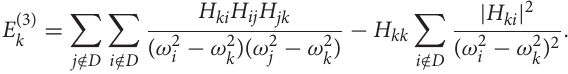
5 and t 1, for which a degenerate coupling set occurs. The = =